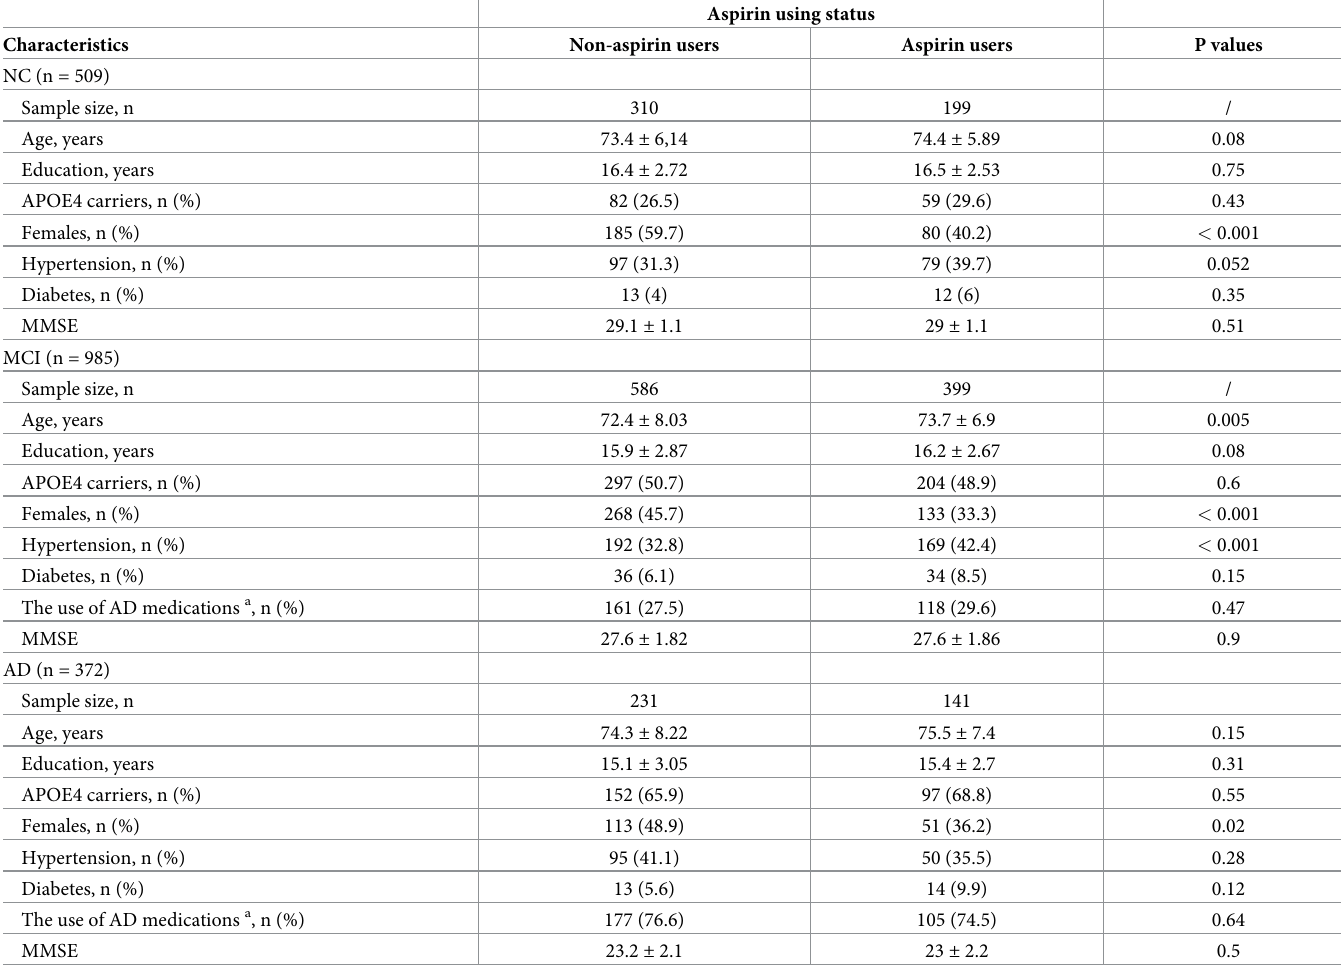
Table 1. Characteristics of three cognitive groups as a function of Aspirin using